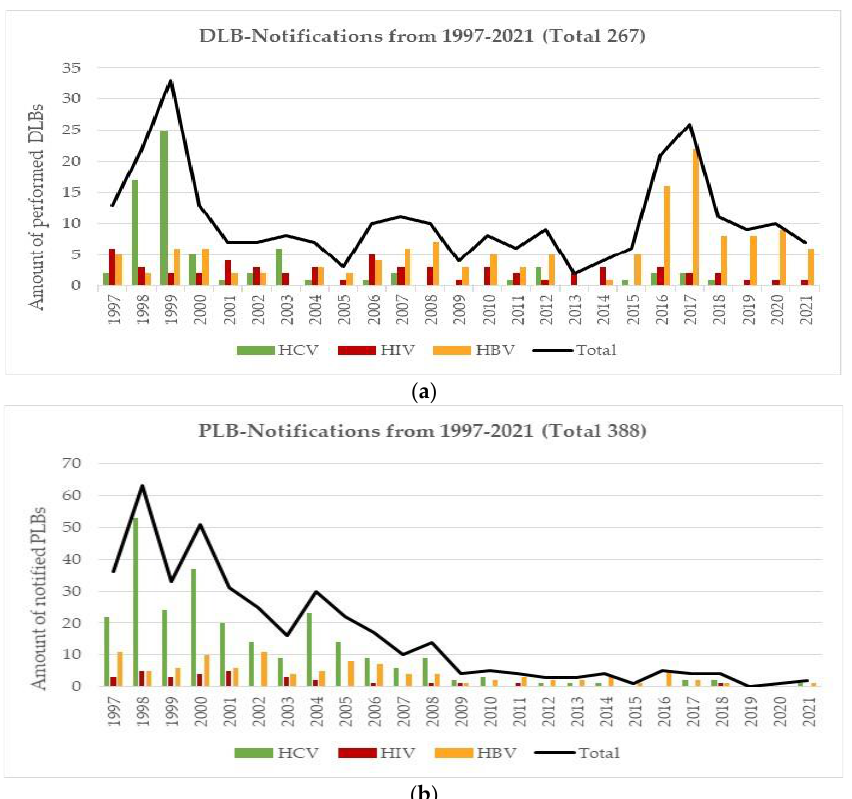
Figure 6. ( a ) DLB notifications between 1997-2021. ( b ) PLB notifications between 1997-2021